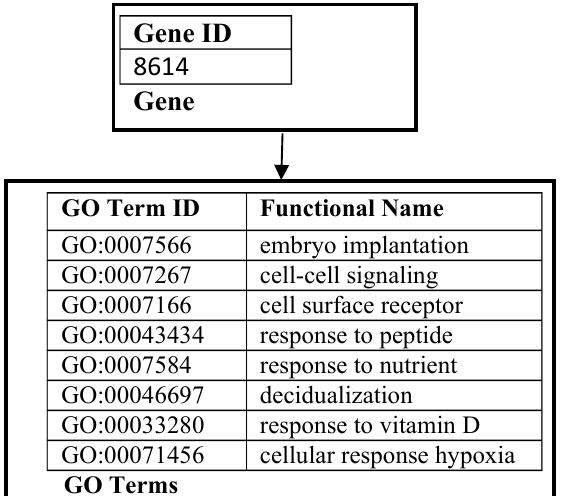
Figure 1. Proposed GO based GEA model